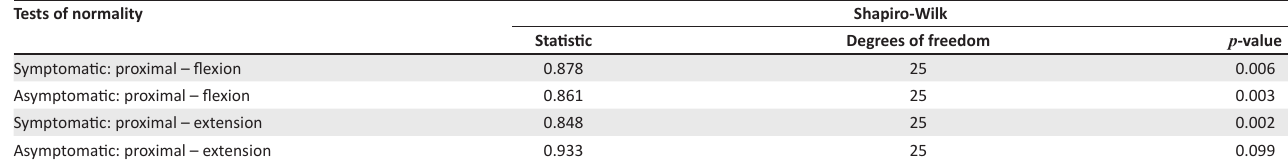
TABLE 3b: Comparison of cross-sectional area measurement of the ulnar nerve, 50 mm proximal to the level of the cubital tunnel.